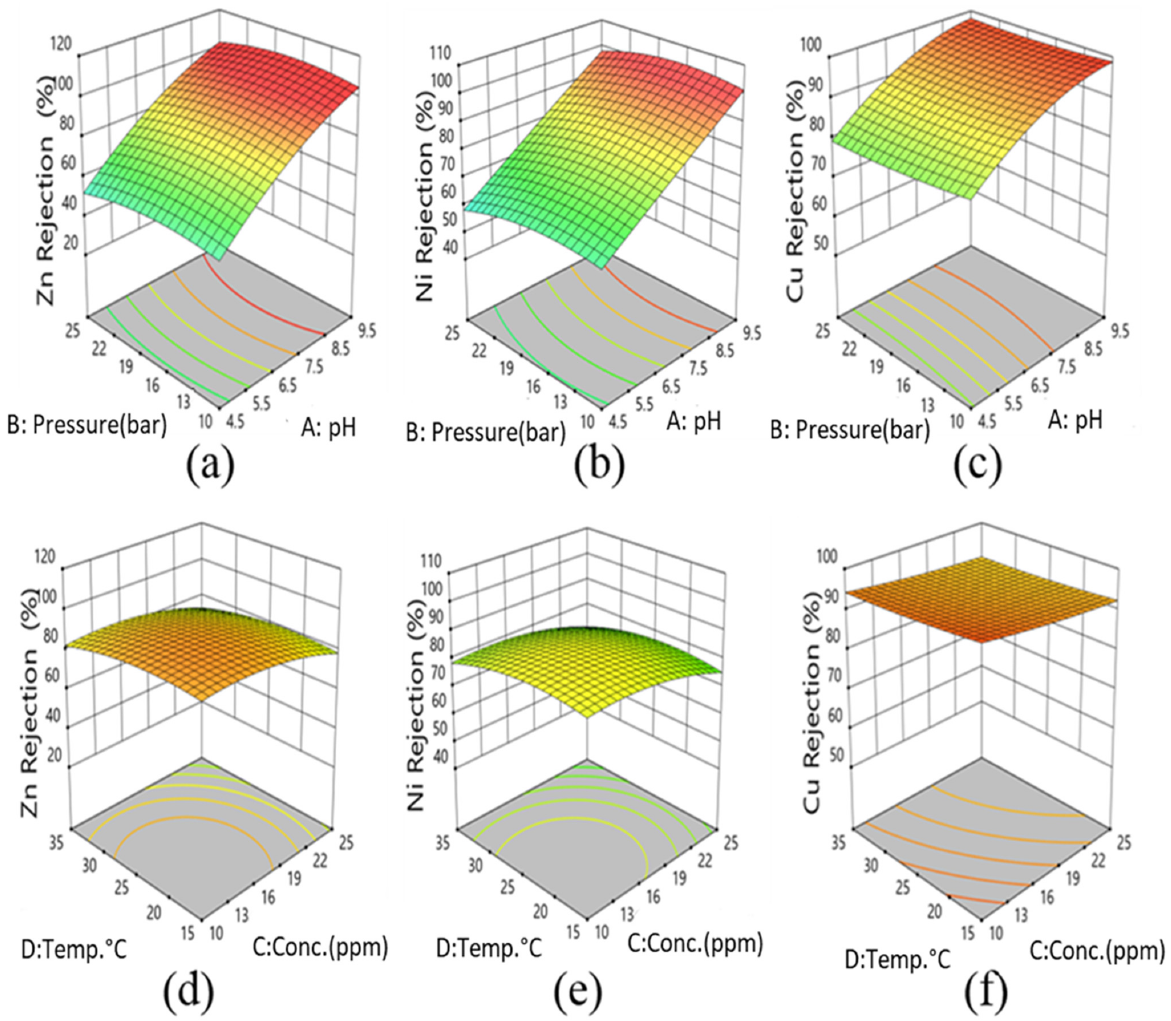
Figure 3. NF membrane RSM plots for pH and pressure effects on metals ions rejection% efficiency—( a ) Zn ions, ( b ) Ni ions, and ( c ) Cu ions; and effect of temperature and concentration on metal ions rejection% efficiency—( d ) Zn ions, ( e ) Ni ions, and ( f ) Cu ions. Table 3. Comparison of rejection efficiency of metals ions by NF membrane between this and other studies in the literature.